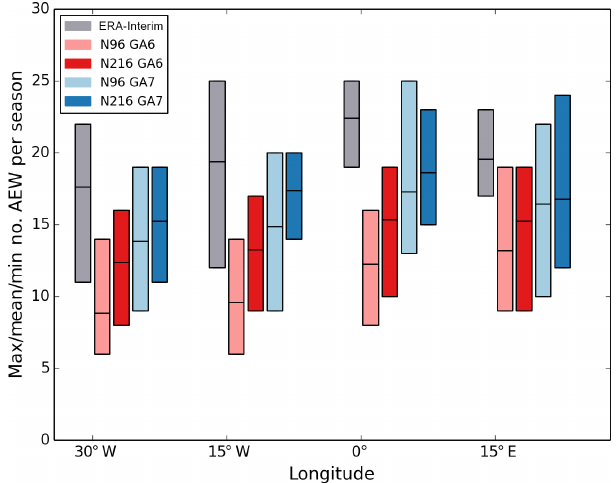
Figure 19. Average, maximum and minimum number of African easterly waves (AEWs) tracked per year (between July and Septem- ber) in the 27-year N216 atmosphere/land-only climate simulations presented in Fig. 12 alongside results from equivalent simulations performed at N96 resolution. These waves are identified and tracked using the algorithm described in Bain et al. (2013).